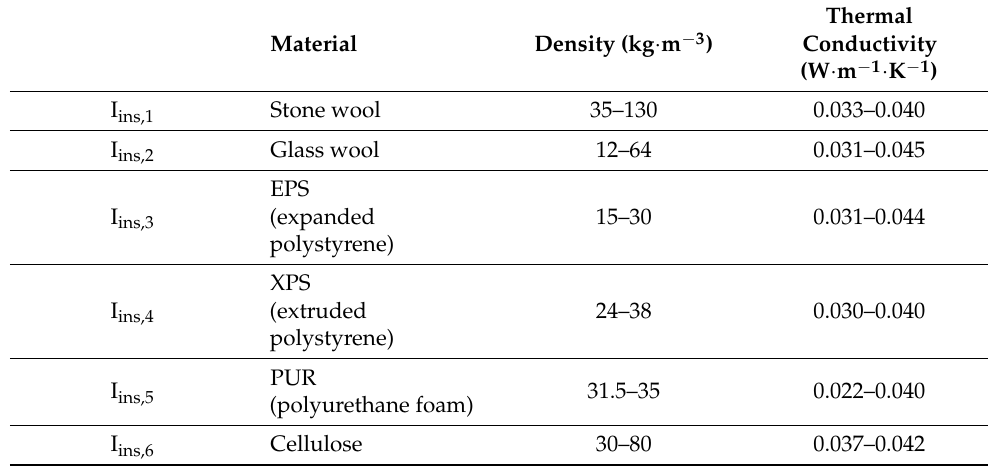
Table 3. Properties of insulation